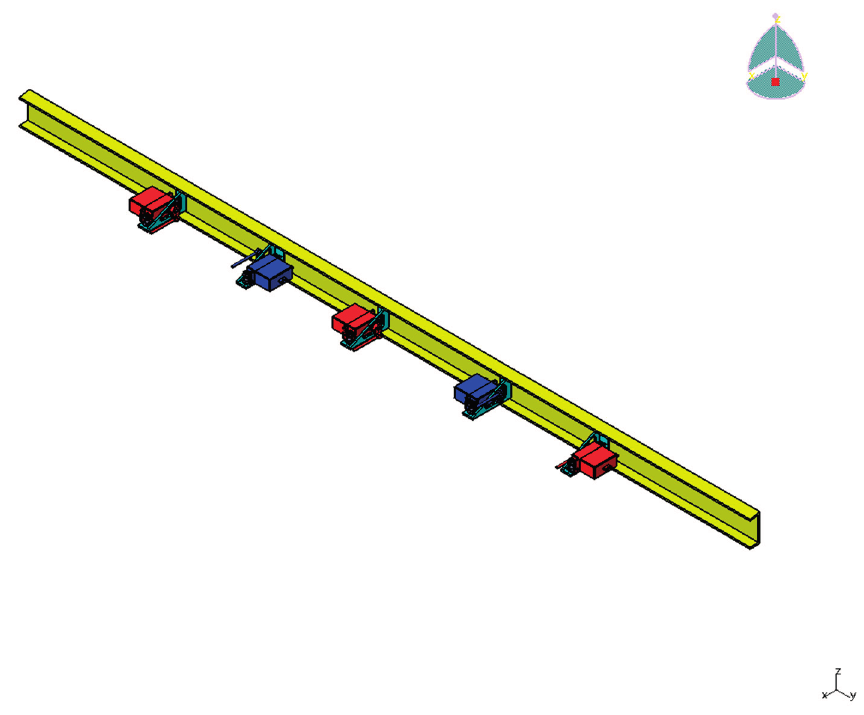
Figure 9. Isometric view of servo actuators in a five servo actuator configuration.